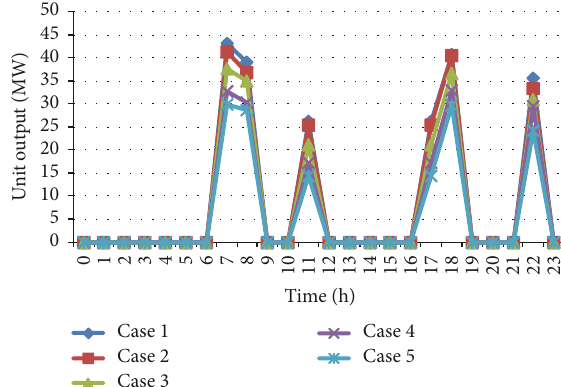
Figure 6: The energy storage power station provides reserve power output curve for VPP.